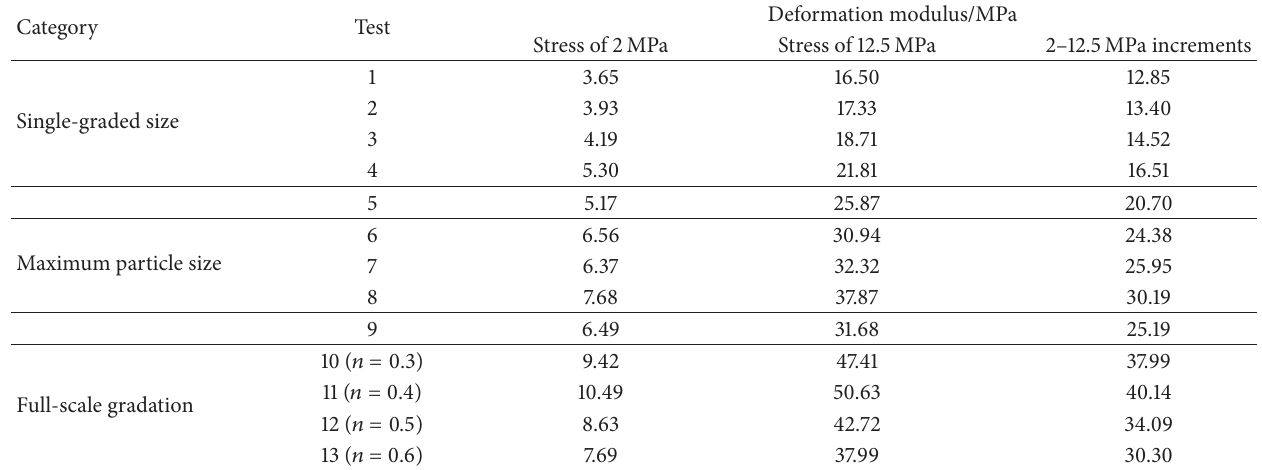
Table 2: Summary of deformation modulus-stress test results.